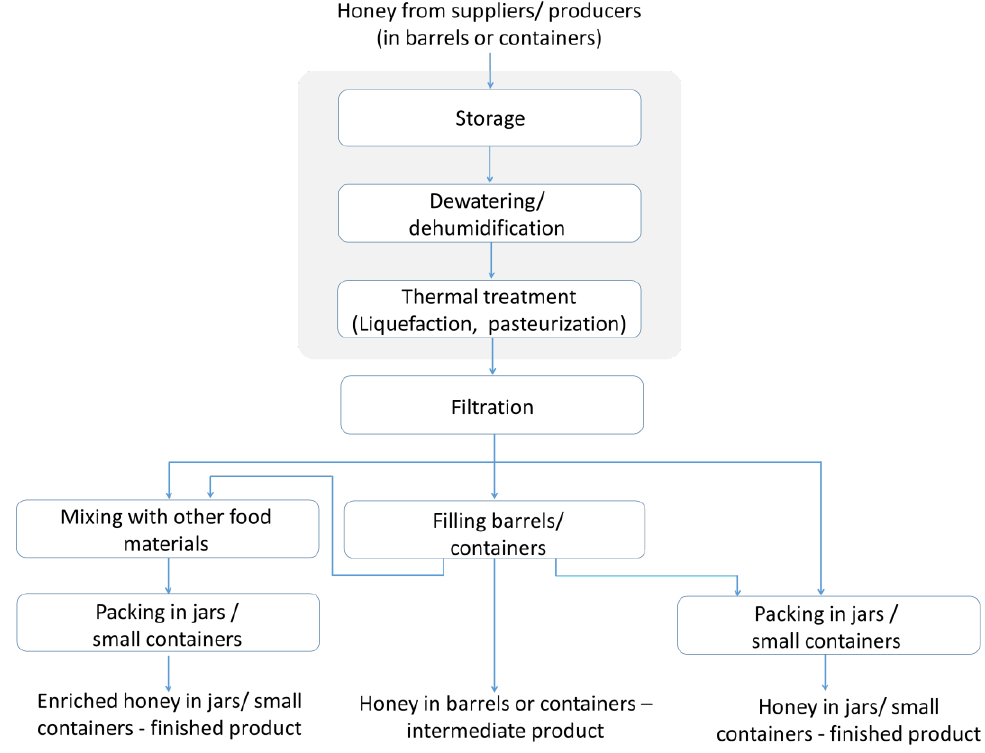
Figure 1. Steps in processing honey from suppliers or producers, highlighting the main operations where modifications can occur.